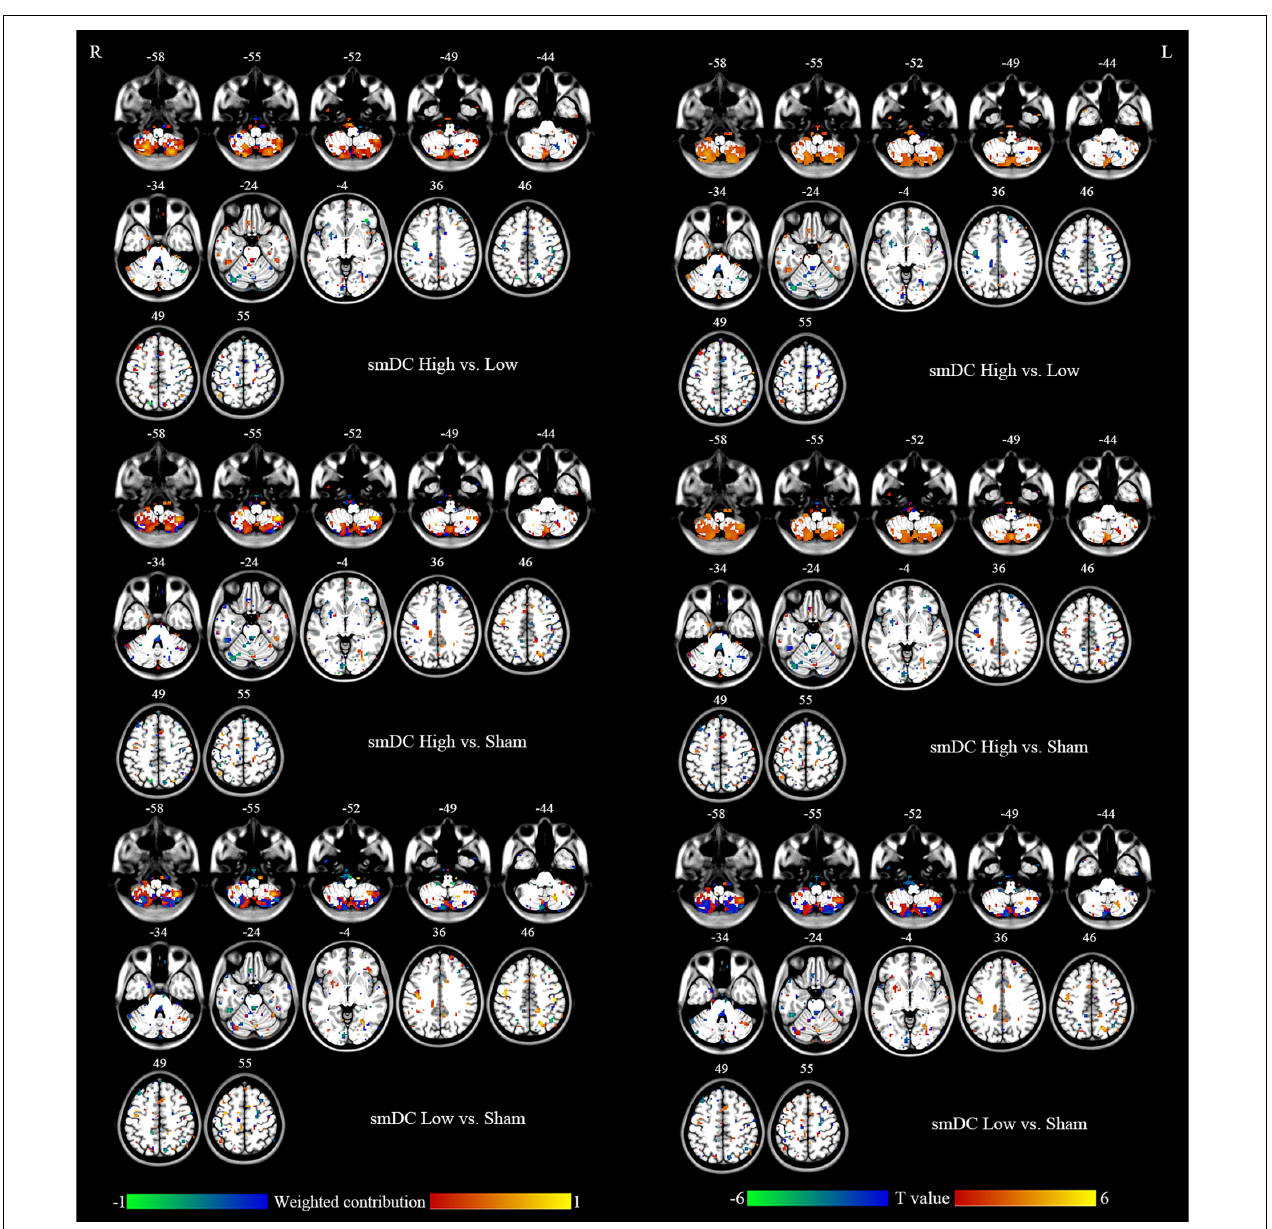
FIGURE 6 | Left column: Brain regions that showed different contributions between stimulation conditions identified by DC maps within the mask of uncorrected F map of ANOVA. Right column: Paired t tests between stimulation conditions on DC maps within the mask of uncorrected F map of